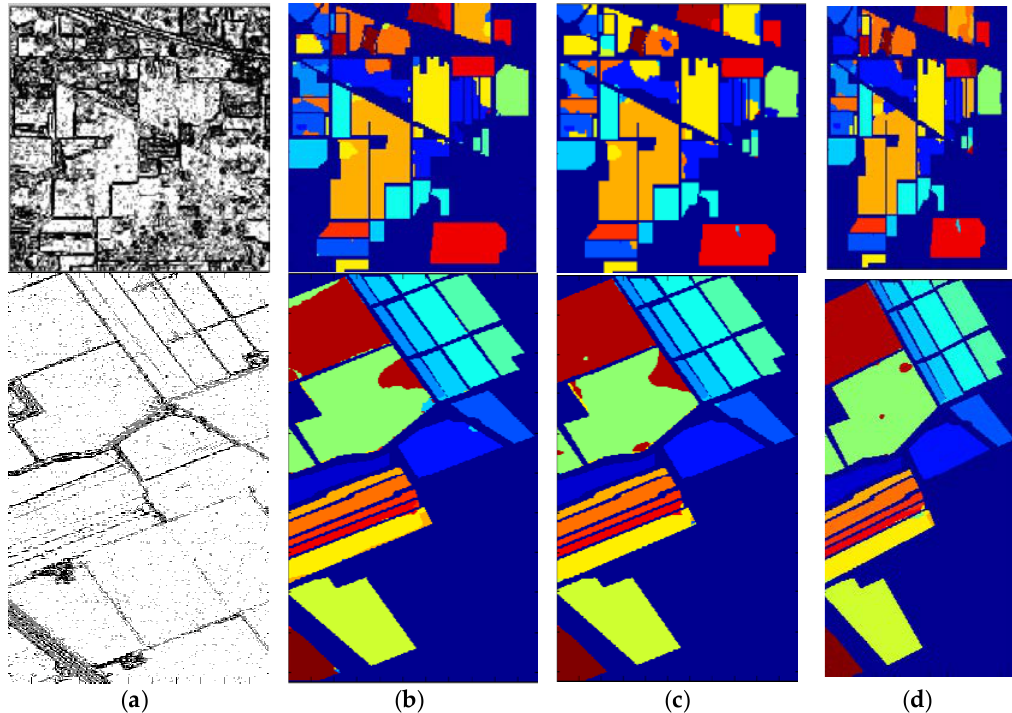
Figure 3. Discontinuity map and classification map obtained by pre-processing + MLRsub + the local mean-based pseudo nearest neighbor (LMPNN) rule + multinomial logistic regression with subspace projection (MLRsub) + post-processing (PMLMP) with different numbers of labeled samples. The above row is for the Indian Pines dataset and the below for the Salinas dataset. ( a ) Discontinuity map. ( b – d ) classification map with 5, 10, and 15 labeled samples per class, respectively. Table 1. Classification results of the Indian Pines and Salinas datasets by different methods with different label proportions.